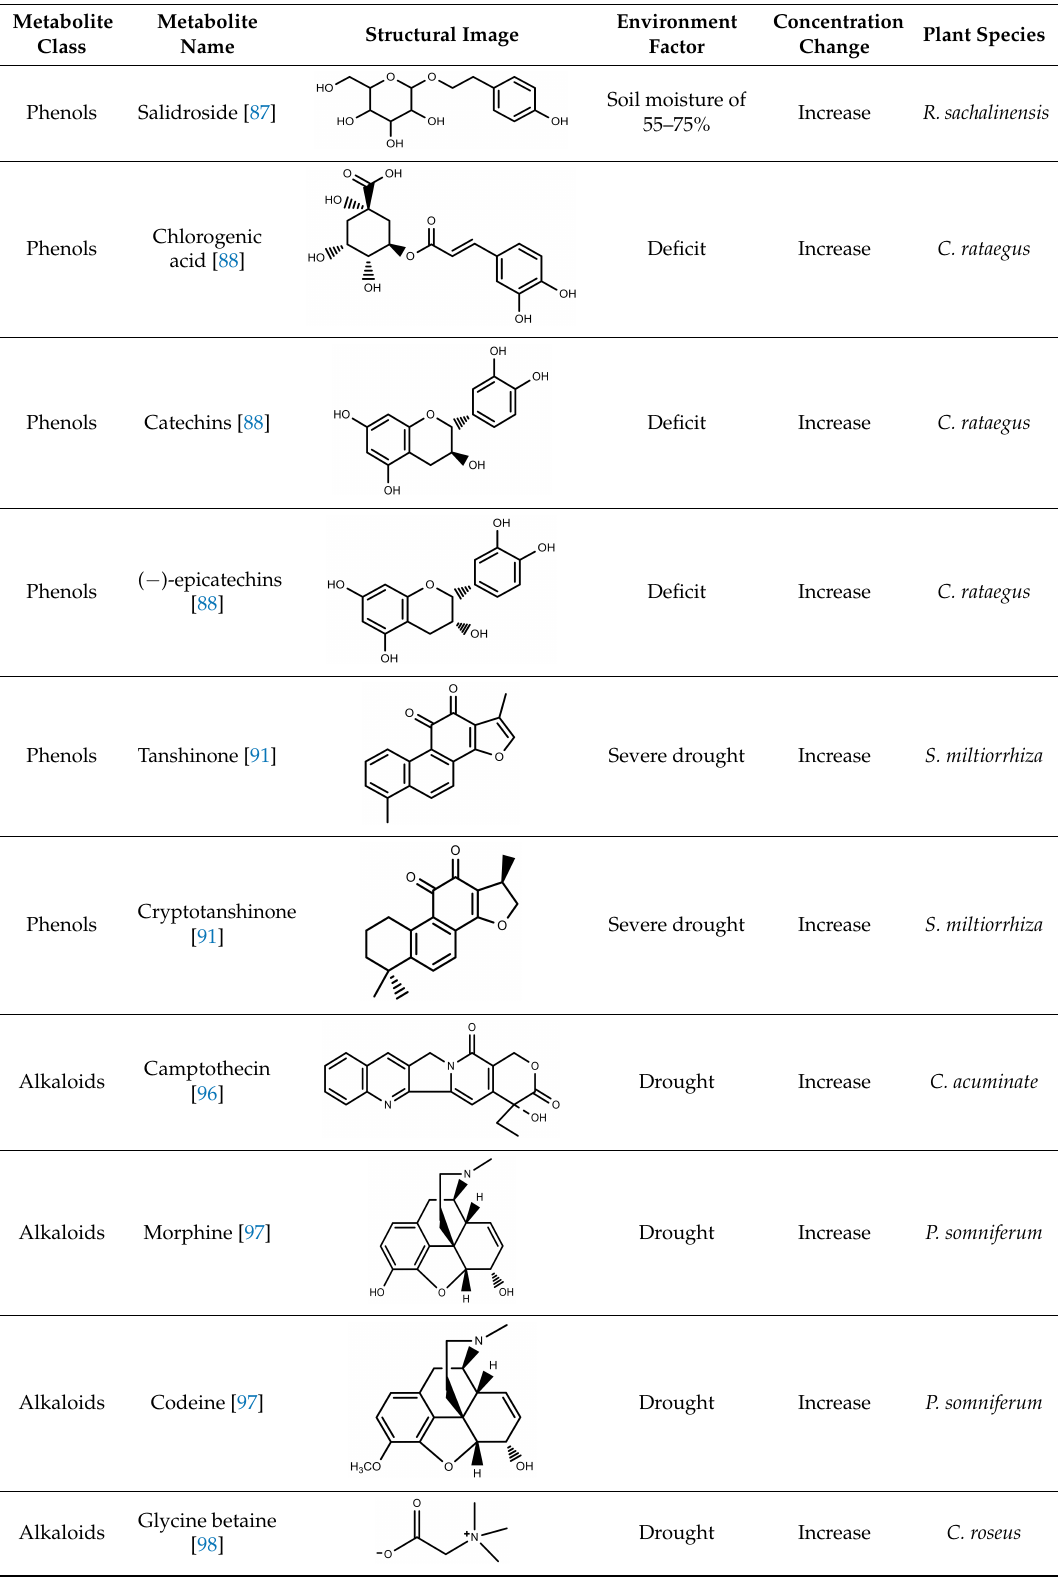
Table 5. Soil water change on the content of various plant